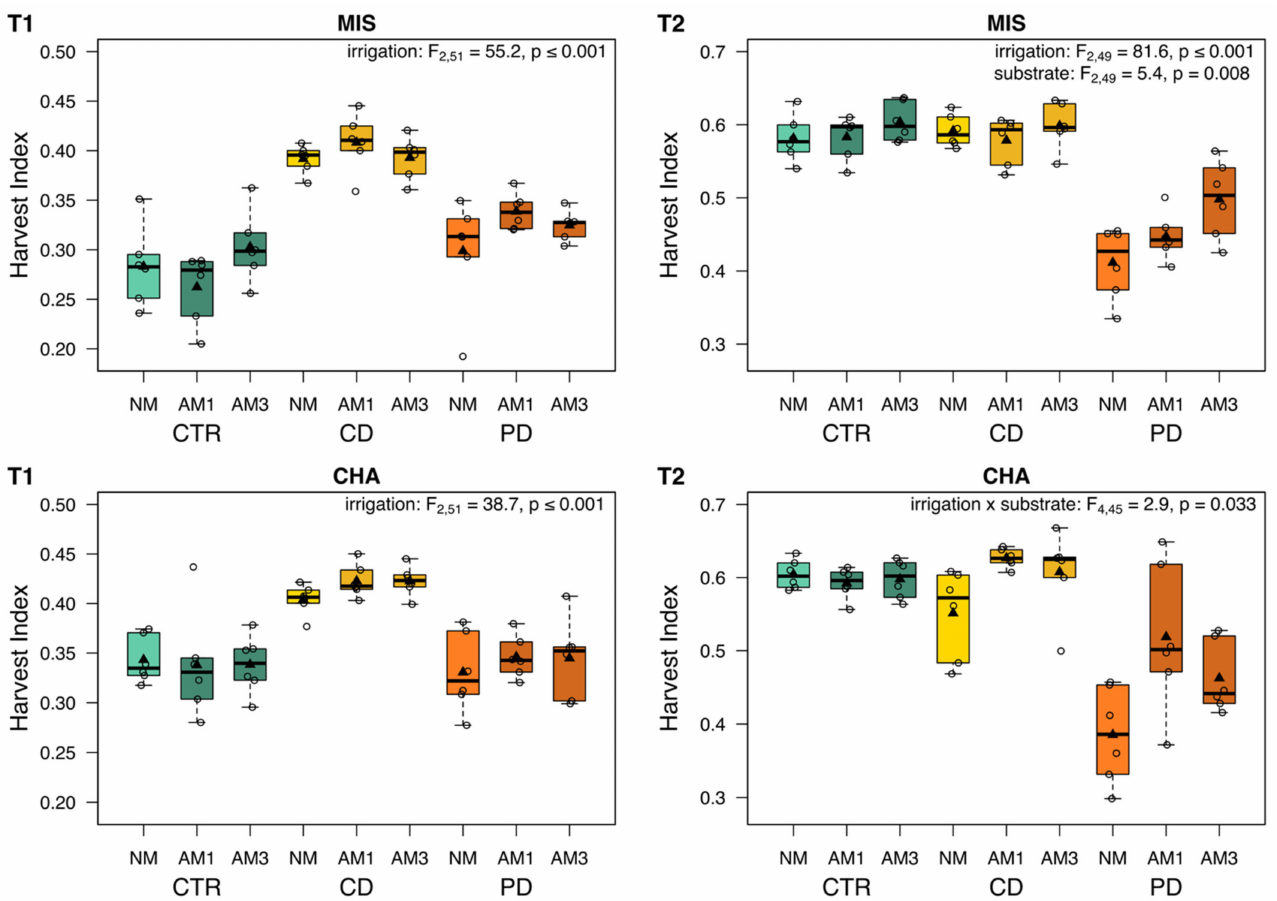
Figure 4. Harvest index of two wheat cultivars [ Triticum aestivum ; Chamsin (CHA), Mistral (MIS)] 67 (T1) and 113 (T2) days post sowing. Cultivation occurred under different irrigation conditions [control (CTR), continuous drought (CD) and pulsed drought (PD), factor: irrigation]. Plants were either non-mycorrhized (NM), mycorrhized with a single fungus (AM1; Rhizoglomus irregulare ) or with a mixture of three fungi (AM3; R. irregulare, Funneliformis mosseae , F. caledonium ) (factor: substrate). Data are given as box–whisker plots with interquartile ranges (IQR; boxes) including medians (horizontal lines), means (triangles) and whiskers (extending to the most extreme data points with maximum 1.5 times the IQR); individual values are given as open circles. The results of linear models are shown comprising the remaining significant terms after model simplification; n =